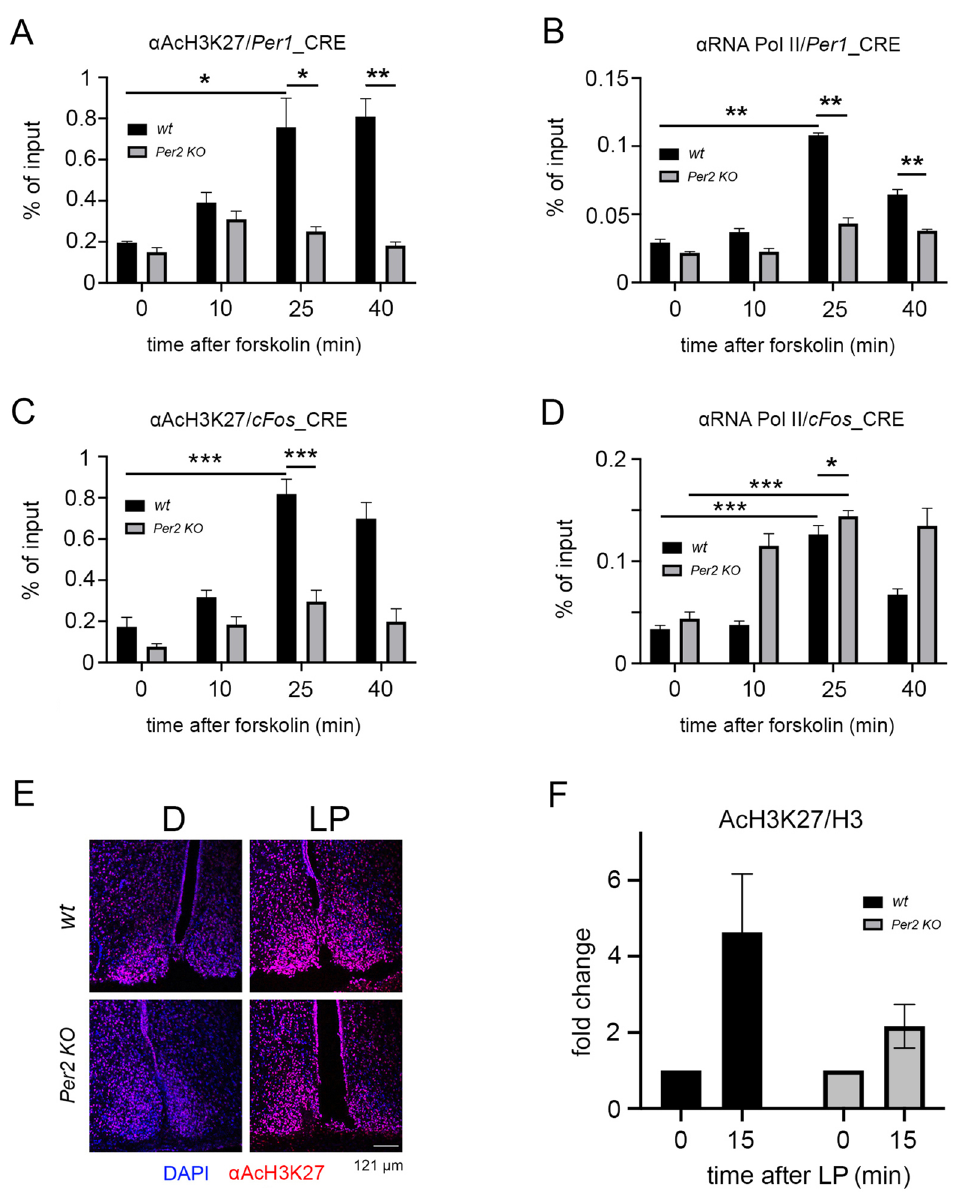
Figure 6. Modulation of CBP-mediated chromatin acetylation of histone H3K27 by PER2. ( A ) Chromatin immunoprecipitation (ChIP) of acetylated histone H3 (AcH3K27) on the CRE-element of the Per1 promoter in wt (black bars) and Per2 KO (grey bars) fibroblast cell lines after forskolin treatment. Values are the mean ± SD. Student’s t-test with Welch’s correction, n = 3, * p < 0.05, ** p < 0.01. Two-way ANOVA indicates a significantly different time profile between the two genotypes, ** p < 0.01. ( B ) The ChIP of RNA polymerase II (RNA Pol II) on the CRE-element of the Per1 promoter in wt (black bars) and Per2 KO (grey bars) fibroblast cell lines after forskolin treatment. Values are the mean ± SD. Student’s t-test with Welch’s correction, n = 3, ** p < 0.01. Two- way ANOVA indicates a significantly different time profile between the two genotypes, *** p < 0.001. ( C ) ChIP with an antibody against AcH3K27 on the Cre-element of the cFos promoter in wt (black bars) and Per2 KO (grey bars) fibroblast cell lines after forskolin treament. Values are the mean ± SD. Student’s t-test with Welch’s correction, n = 3, *** p < 0.001. ( D ) ChIP of RNA Pol II on the CRE-element of the cFos promoter in wt (black bars) and Per2 KO (grey bars) fibroblast cell lines after forskolin treatment. Values are the mean ± SD. Student’s t-test with Welch’s correction, n = 3, * p < 0.05, *** p < 0.001. ( E ) Immunohistochemistry (IHC) on wt and Per2 KO SCN before and after a light pulse (LP) at ZT14. AcH3K27 (red signal) is stronger after LP in wt compared to Per2 KO SCN. Scale bar: 121 µm. ( F ) Quantification of 3 independent Western blot experiments of wt and Per2 KO SCN before and after an LP at ZT14. Acetylation of H3K27 is increased after an LP with a tendentially lower increase in Per2 KO. Two-way ANOVA, p =